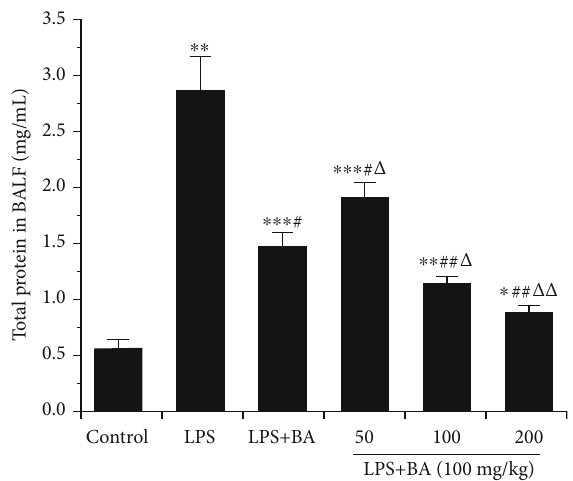
Figure 4: BA alleviates the total proteins in BALF induced by LPS. After 12 h of LPS administration, mice were sacri fi ced to get the BALF. The values were presented as means ± SD ( n = 4 ). ∗ P < 0 : 05 , ∗∗ P < 0 : 01 , and ∗∗∗ P < 0 : 001 vs. the control group; # P < 0 : 05 and ## P < 0 : 01 vs. the LPS group; and △ P < 0 : 05 and △△ P < 0 : 01 vs. the LPS+BA